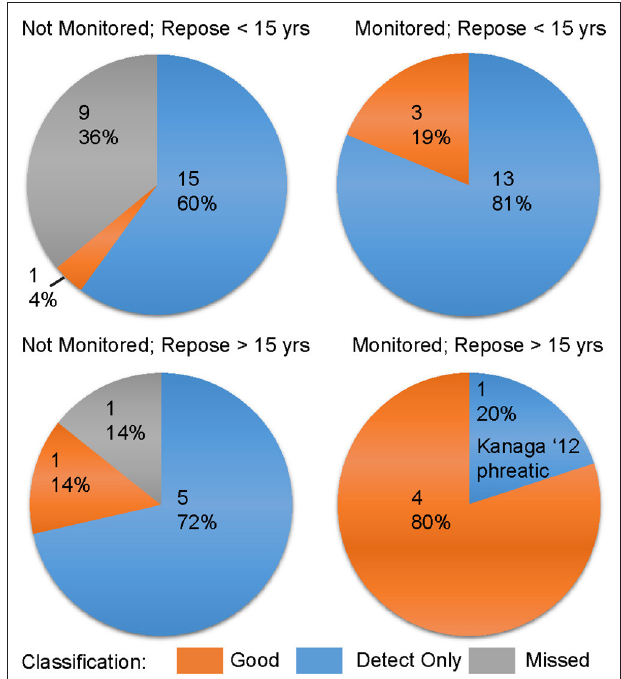
FIGURE 9 | Four pie charts, showing event-notification classes for eruptions, based on seismically monitored/unmonitored status and repose less than or greater than 15 years. Number of eruptions and percentage of the pie are shown in each slice. For the lower right pie chart, showing those eruptions with both seismic monitoring and repose times longer than 15 years, Kanaga 2012 (the single not-forecast event) is the only phreatic eruption of this